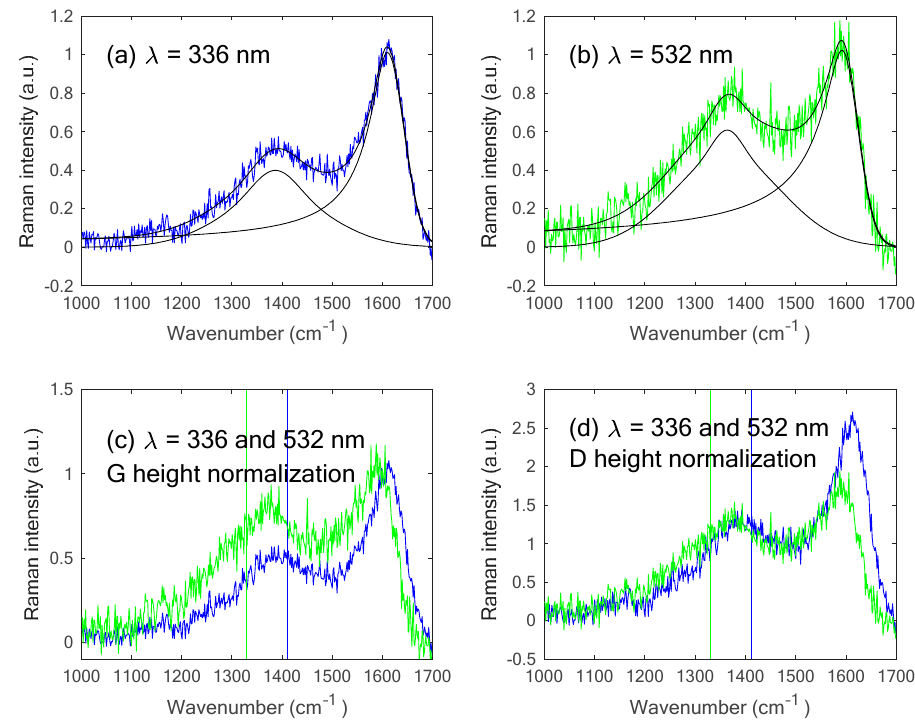
Figure 2. Raman spectra of the Barnett gas-shale obtained with an excitation wavelength of ( a ) 336 nm and ( b ) 532 nm. The fitting and its components (black lines) are also shown but the sub-bands are not represented for clarity. ( c ) and ( d ) show comparisons of both previous spectra (blue: 336 nm spectrum; green: 532 nm spectrum) while normalizing them using the G band intensity ( c ) and the D band intensity ( d ). The vertical lines represent the position of the D band for graphite for each excitation energy.